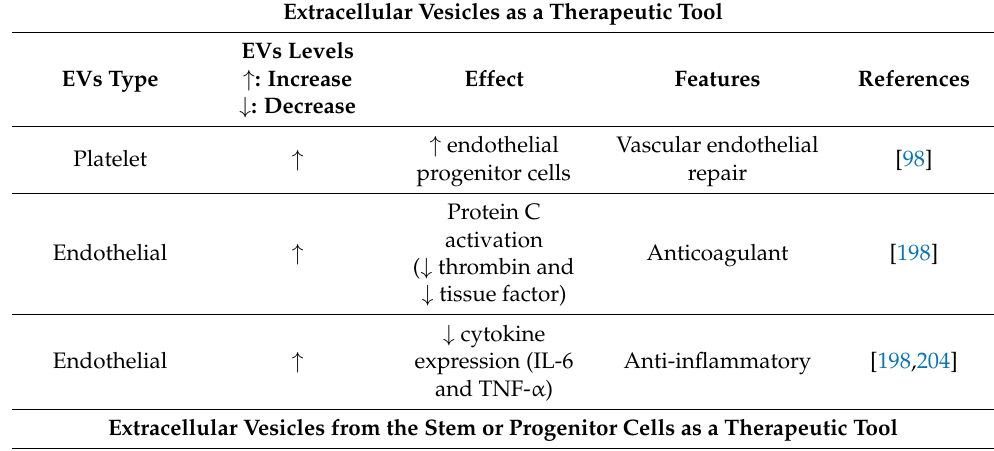
Table 4. EVs as treatment (therapeutical